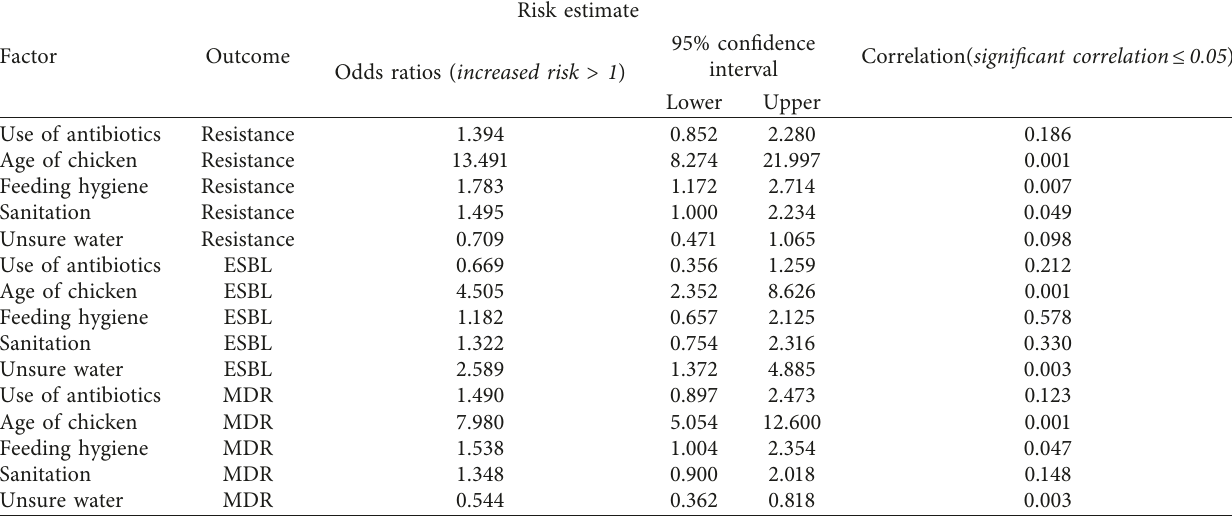
Figure 6: Association of various resistance phenotypes among isolates. Table 8: Association of risks to resistance outcomes.